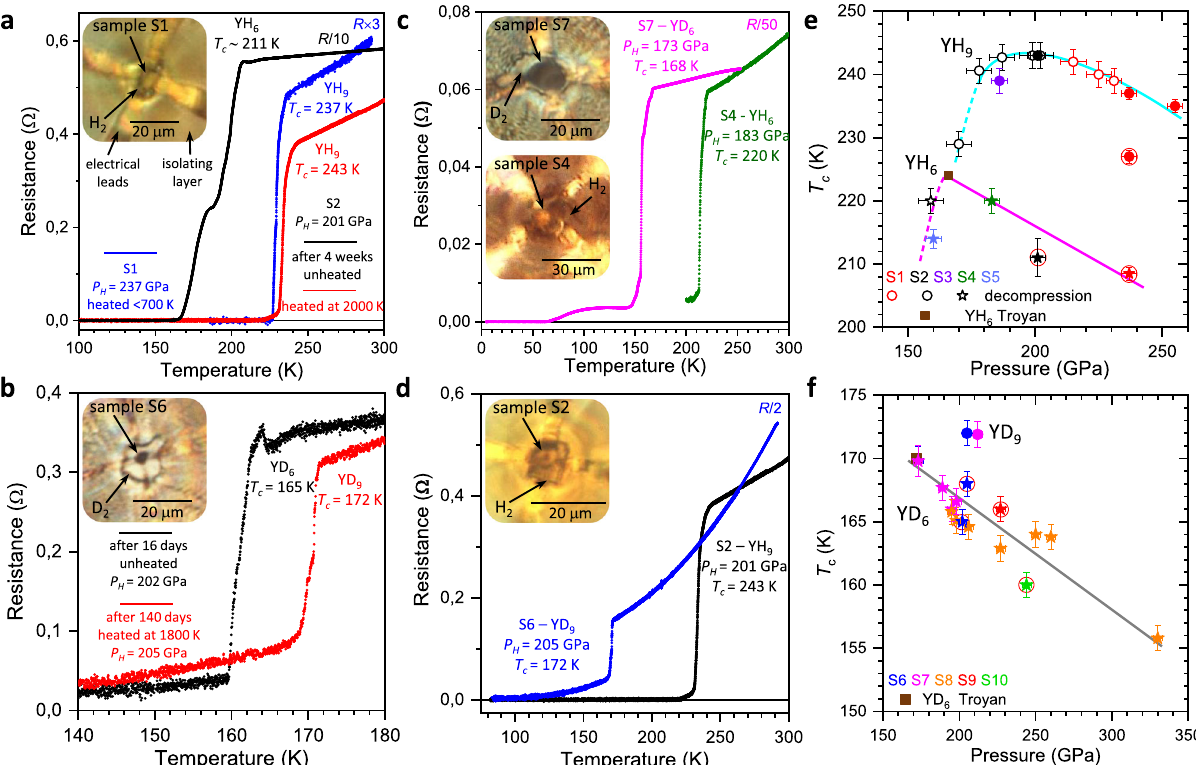
Fig. 4 Superconducting transitions in the synthesised yttrium hydrides and deuterides. a , b The temperature dependencies of the resistance of the yttrium-hydrogen and yttrium-deuterium samples measured with a four-probe technique in a van der Pauw geometry, demonstrating the shift in T c to higher temperatures after pulsed laser heating of the samples. In a , Black and red curves correspond to the temperature dependence of the resistance of the Im-3m YH 6 phase, which was formed after exposing YH 3 to H 2 at P H = 201 GPa for 3 weeks, and the P6 3 /mmc YH 9 phase, which was synthesised after subsequent heating at 2000(10)K, in sample 2. The blue curve corresponds to the P6 3 /mmc YH 9 phase synthesised at P H = 237 GPa in sample 1 (S1). In b , similarly, T c increases from 165 K for Im-3m YD 6 to 172 K for P6 3 /mmc YD 9 in sample 6 (S6) at P H ∼ 205 GPa. c , d The temperature dependencies of the resistance of Im-3m YH 6 (YD 6 ) and P6 3 /mmc YH 9 (YD 9 ) synthesised in samples 2, 4, 6 and 7 (S2, S4, S6, S7) demonstrate the shift in the superconducting transitions with isotopic substitution. The absolute resistance values for some samples were multiplied by the speci fi ed constant factors for better presentation. The insets show photos of the samples and arrangements for electric transport measurements. e , f The pressure dependence of T c for the superconducting transitions in Im-3m YH 6 (stars) and P6 3 /mmc YH 9 (circles) phases and the corresponding deuterides, respectively. Different colours represent different samples. Open symbols are the data obtained on subsequent decompression. Symbols marked by red circles are the data for unheated samples. Cyan, magenta and grey curves are the guides for the eye. Brown squares depict the data from Troyan et al. 26 . Error bars are de fi ned the same as in Drozdov et al. 12 . The horizontal and vertical error bars correspond to the uncertainty in the precise value of the pressure (inherent error bars of the method used) and in the determination of the correct value of T c (criteria-dependent),